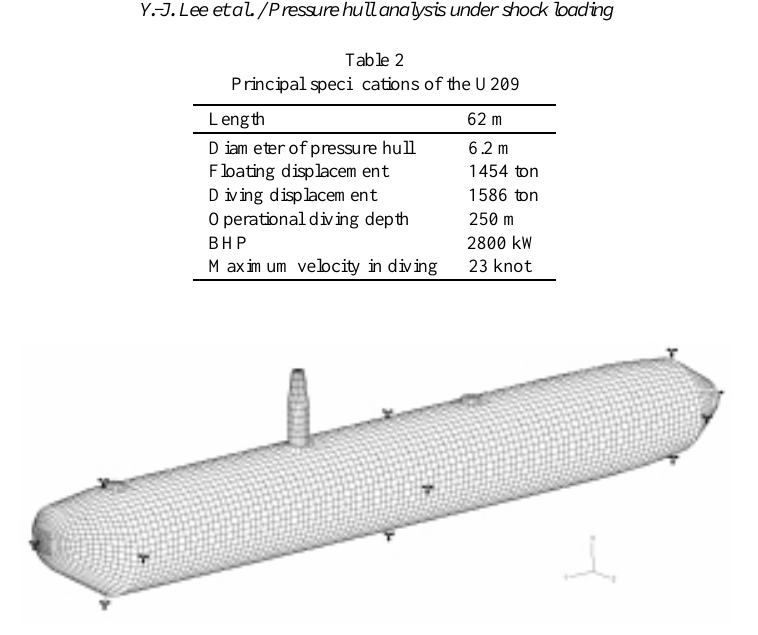
Fig. 3. Pressure hull